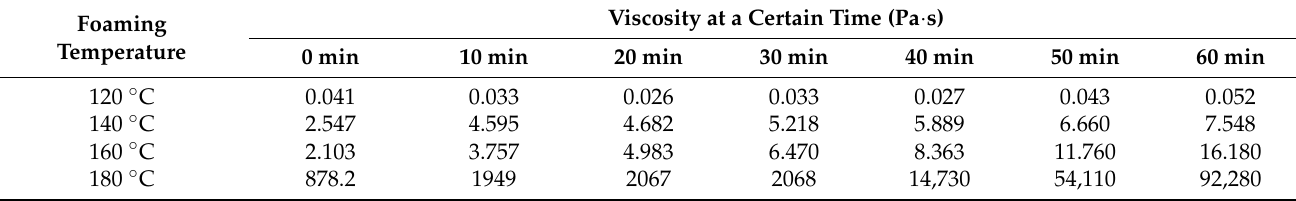
Table 2. Viscosity at a certain time under various